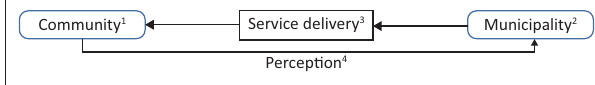
FIGURE 1: Basic conceptual